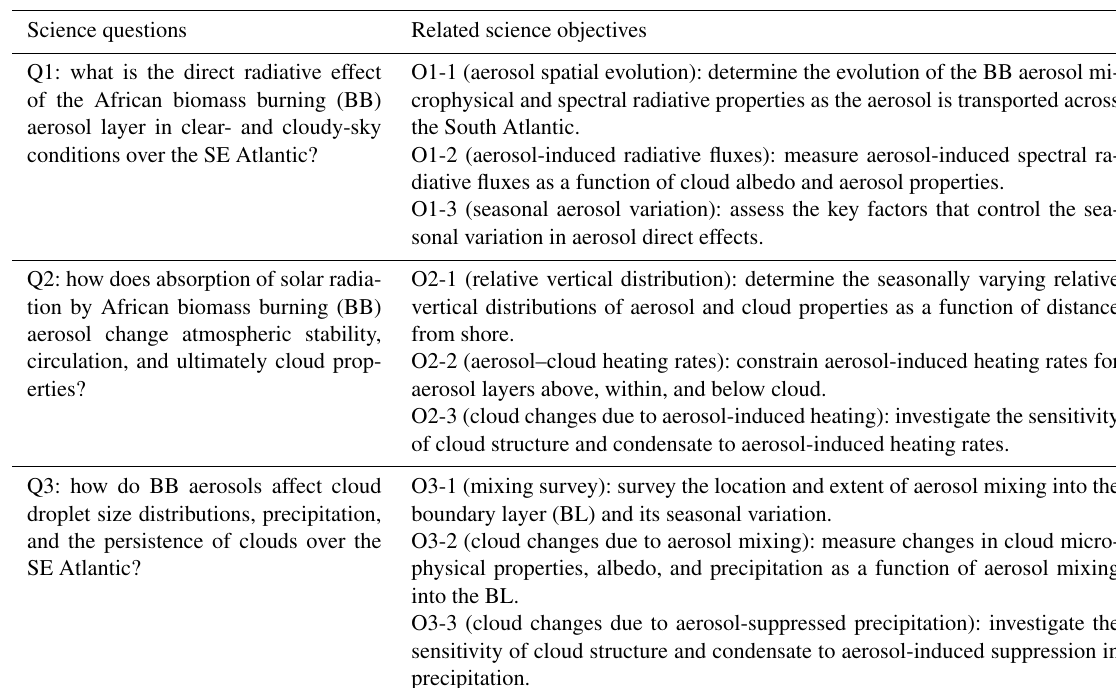
Figure 3. Aerosol optical depth at 440/441nm (a) from AERONET sites in southern Africa peaks in early September, while SSA at 440/441nm (b) shows a significant increase between August and November. Red circles in the inset indicate the few stations operating between 2011 and 2013. Both panels contain data from 1995 to 2013 to represent the state of knowledge prior to the ORACLES deploy- ments. Table 1. A summary of ORACLES science questions and related